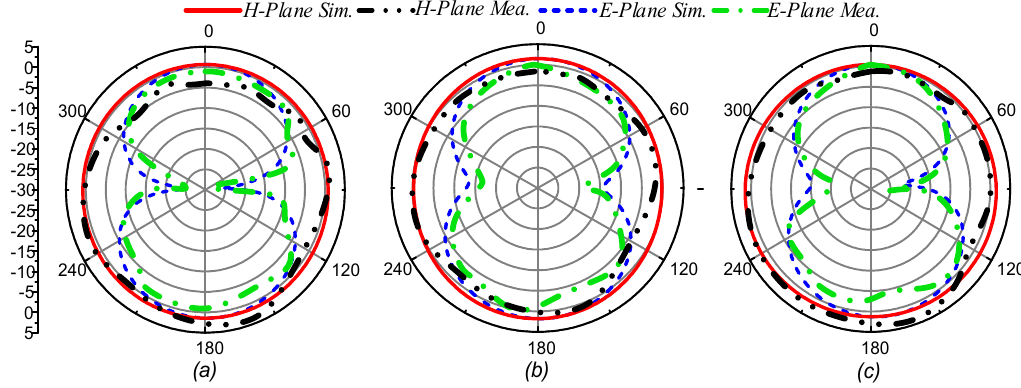
Figure 10. Simulated and measured radiation patterns for case-00: ( a ) 2.24 GHz ( b ) 2.74 GHz ( c ) 3.71 GHz.